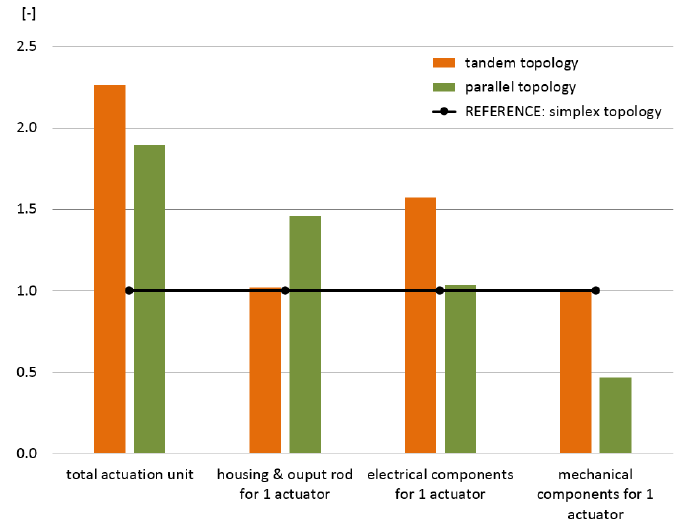
Figure 22. Mass evolution of tandem or parallel topologies compared to simplex